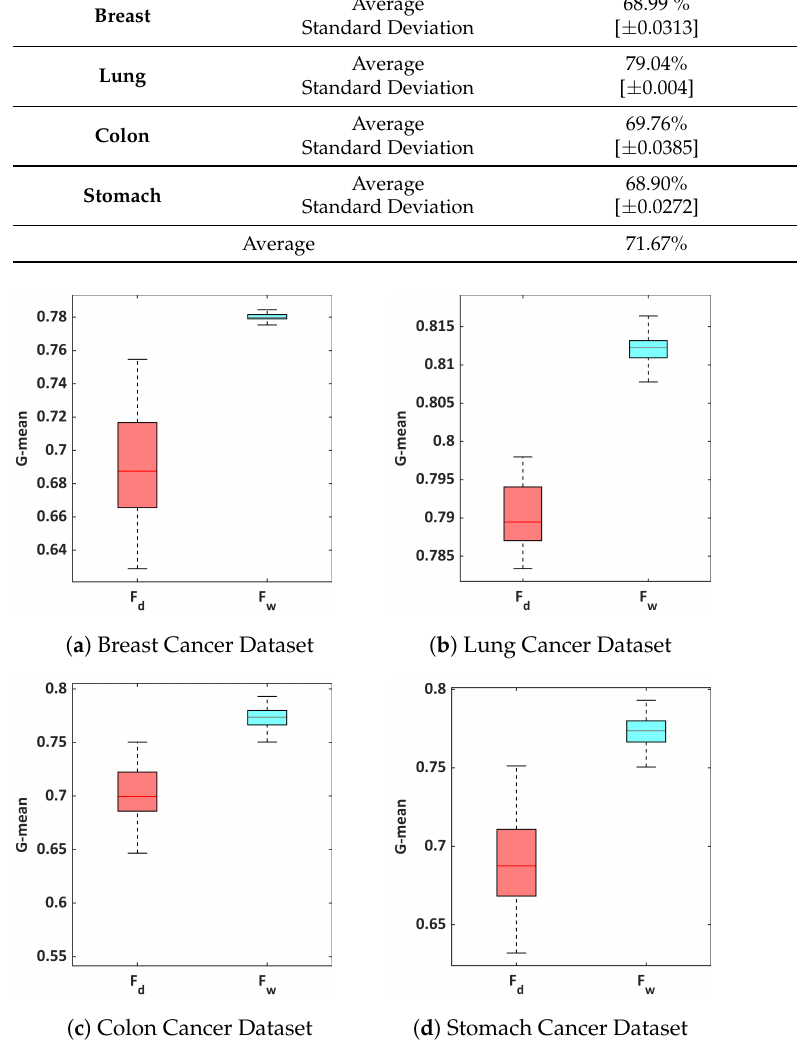
Figure 3. Box plots of the G-mean results obtained by F d and F w for Breast, Lung, Colon, and Stomach Cancer datasets. The red bar inside the box represents the median; the upper whisker represents the maximum value; the lower whisker represents the minimum